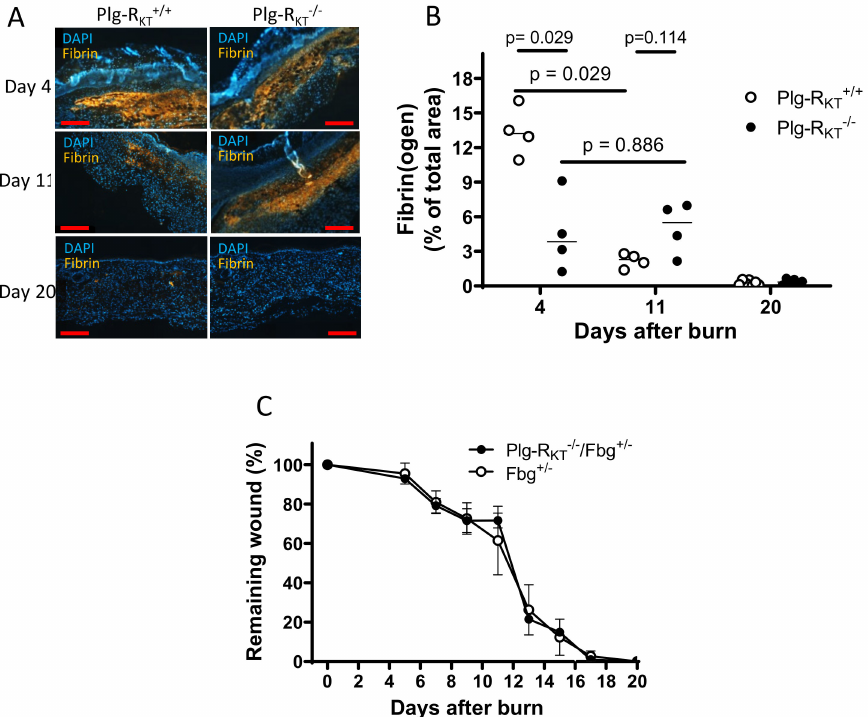
Figure 3. Enhanced fibrin(ogen) content in Plg-R KT − / − wound tissue and effect of fibrinogen het- erozygosity on burn wound healing. ( A ) Immunohistochemical staining for fibrin in the tissue of Plg-R KT − / − and Plg-R KT+/+ mice collected at different time points after induction of burn wounds ( n = 4). Scale bar = 200 µ m. ( B ) Quantification of fibrinogen area in Panel A (%) based on immunos- taining using Image J software https://imagej.nih.gov/ij/download.html. ( C ) Quantification of the remaining wound area at different time points after burn wounding of male Plg-R KT − / − /Fgn +/ − ( n = 4) mice and Plg-R KT +/+ /Fgn +/ − mice ( n = 5). Post hoc testing was done by Mann–Whitney test. at: